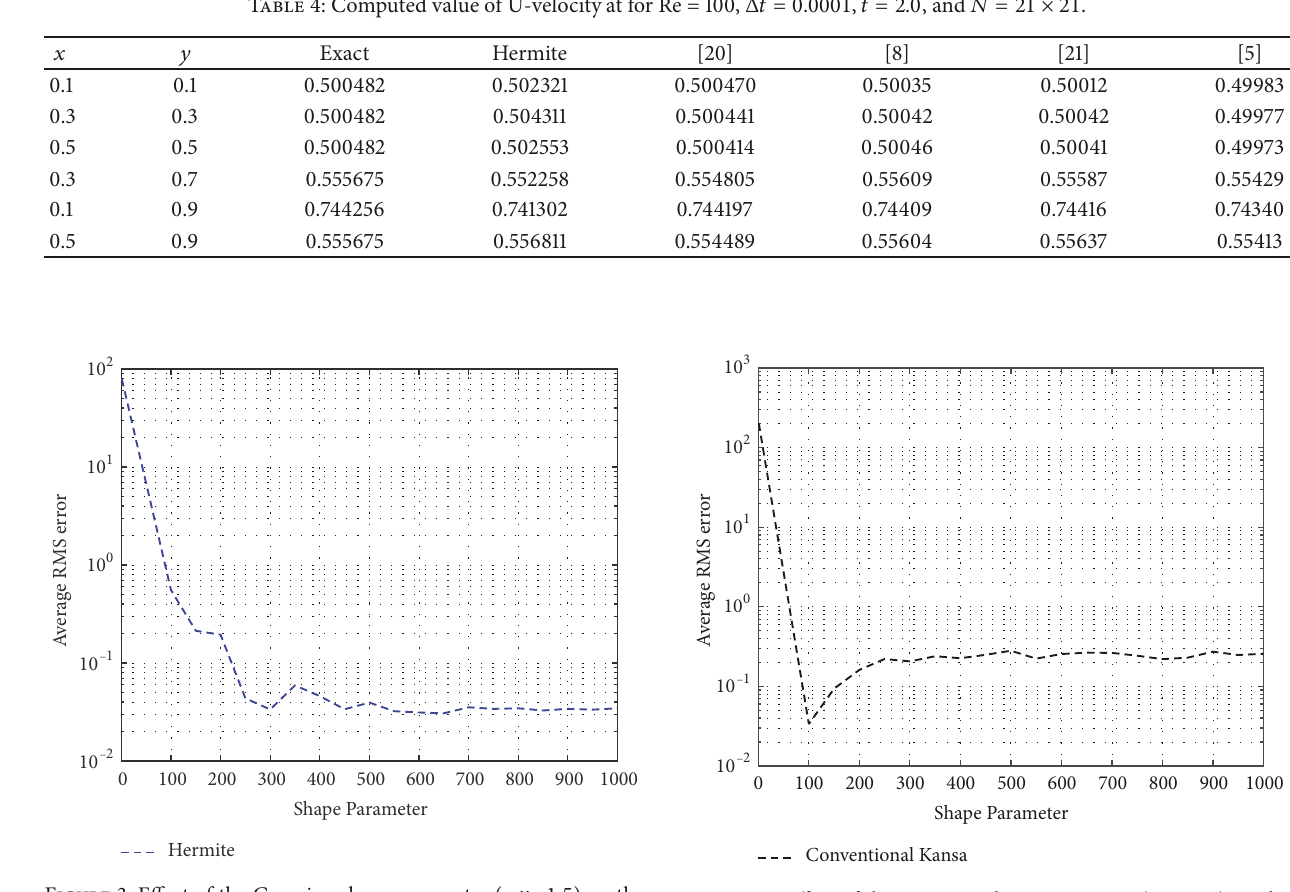
Once again, reasonably good quality of computed solutions is obtained.